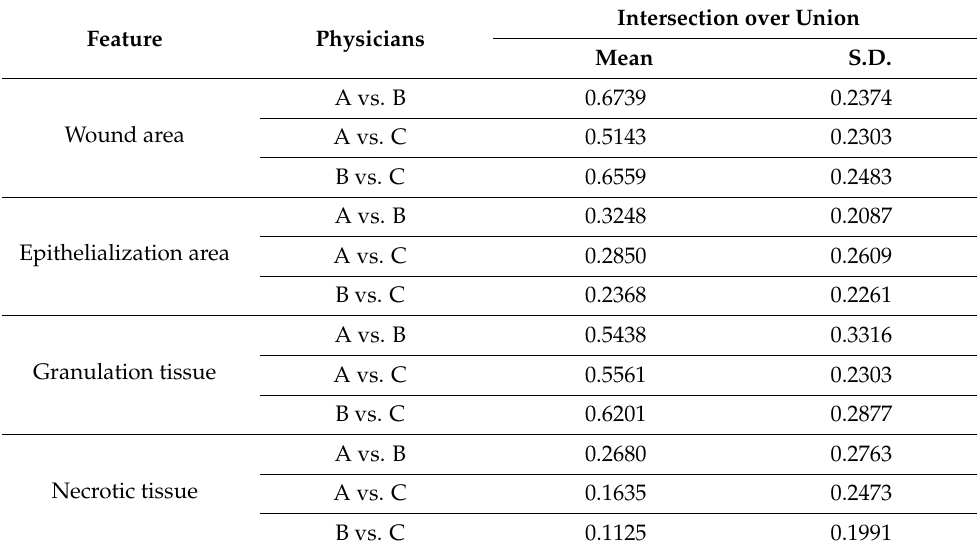
Table 4. Inter-rater agreement between physicians on each class